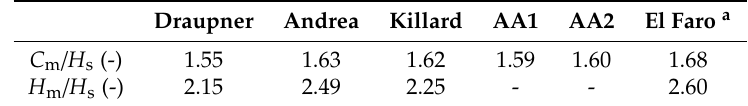
Table 1. Crest and crest-to-trough maximum wave height parameters of iconic rogue waves (namely Draupner, Andrea, Killard, and El Faro; [6,8]) and of maximum waves AA1 and AA2 gathered within space-time fields of sea elevation